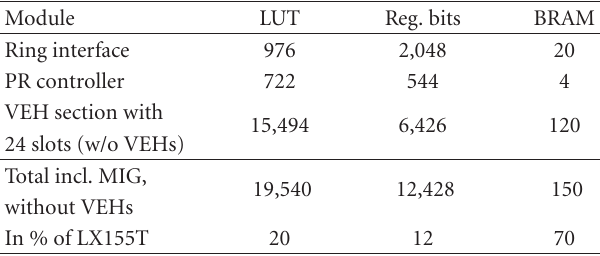
Table 2: Synthesis results for VEH node components.